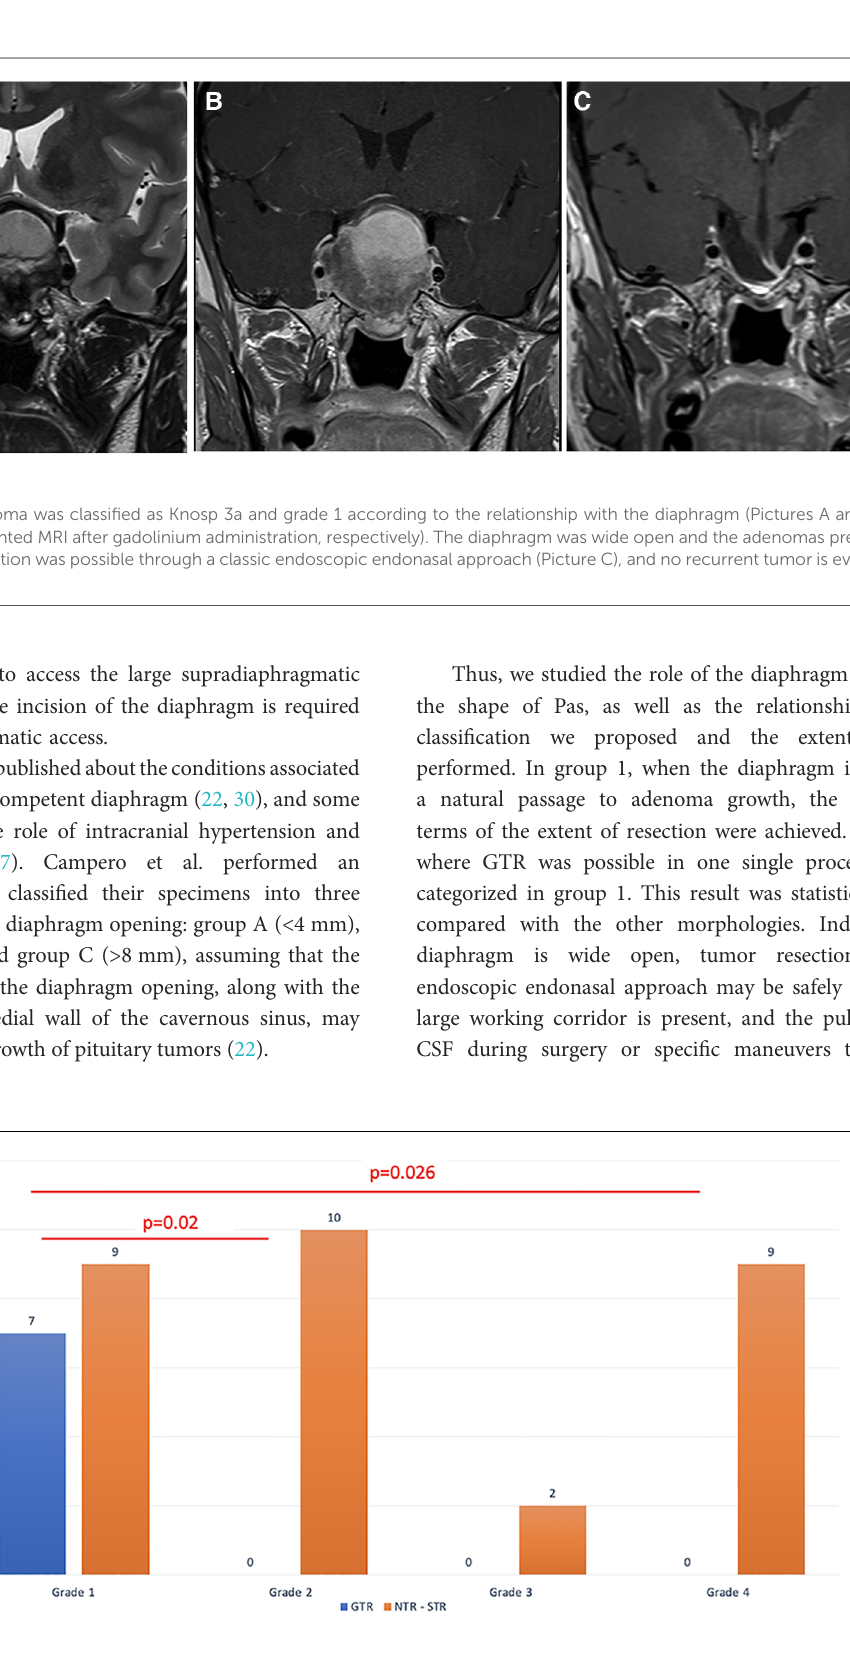
FIGURE 3 The extent of resection is detailed based on the relationship between the tumor and the